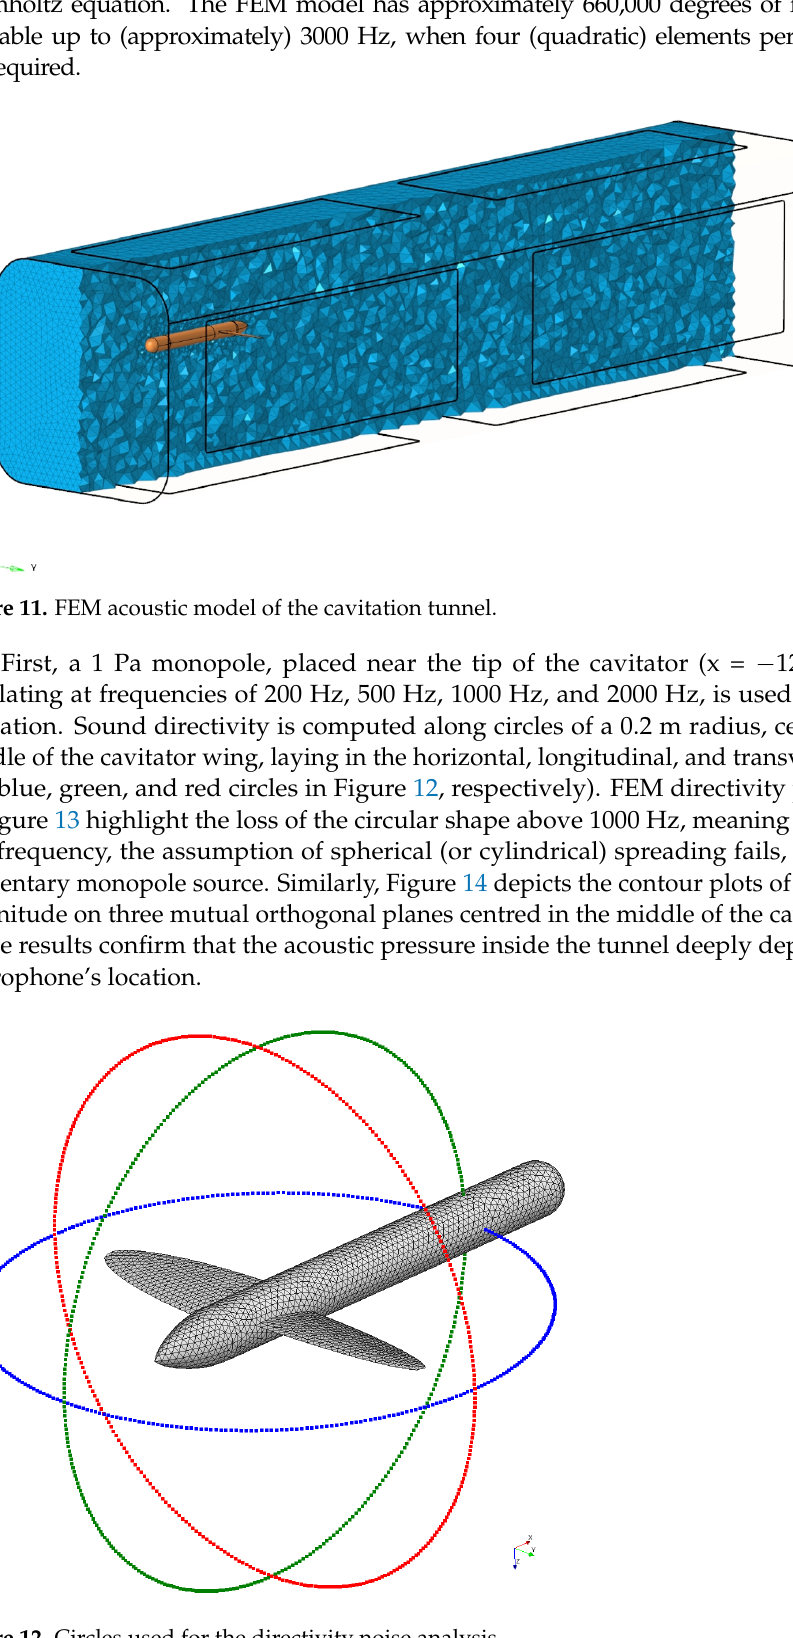
Figure 12. Circles used for the directivity noise